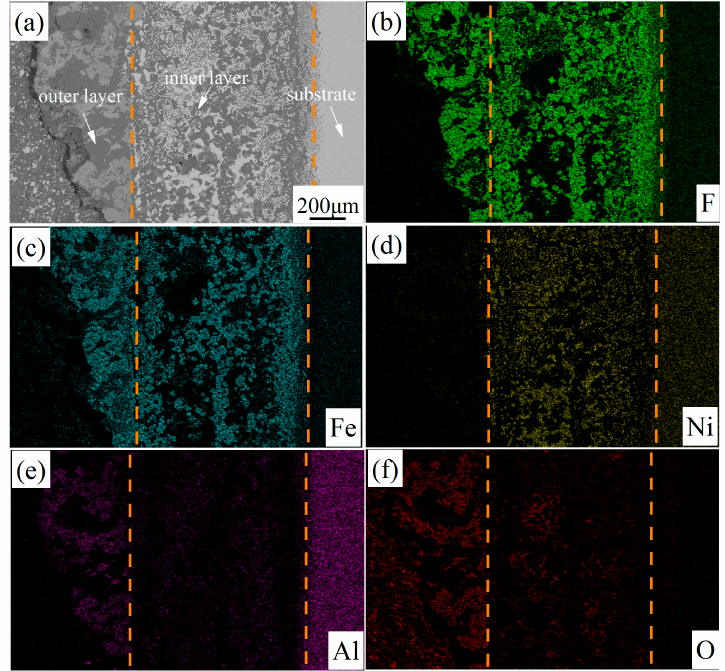
Figure 4. The SEM cross-section micrograph ( a ) and EDS mapping with respect to F ( b ), Fe ( c ), Ni ( d ), Al ( e ), and O ( f ) of 58.2Fe-40.4Ni-1.4Al alloy after electrolytic corrosion